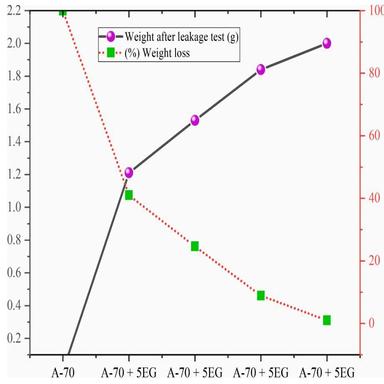
Leakage proof performance evaluation of PCM and SS-PCM composites considering weight loss and the weight loss percentage during the leakage test.